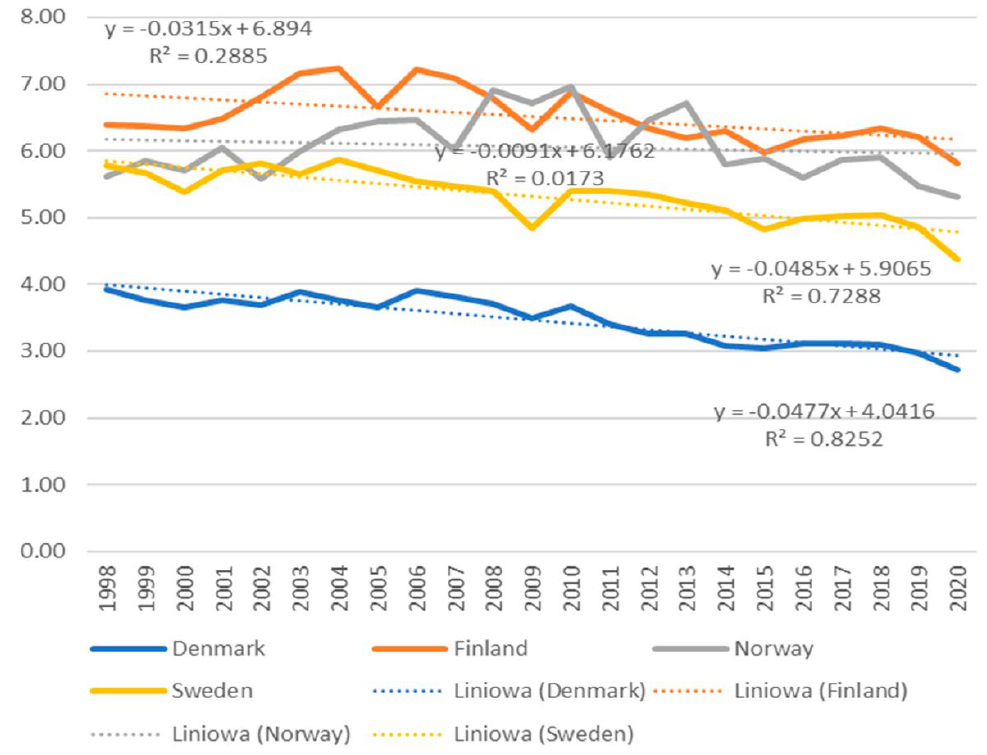
Figure 3. Energy consumption per capita (thousand tons oil equivalent). Source: Nordic Statistics database [31].